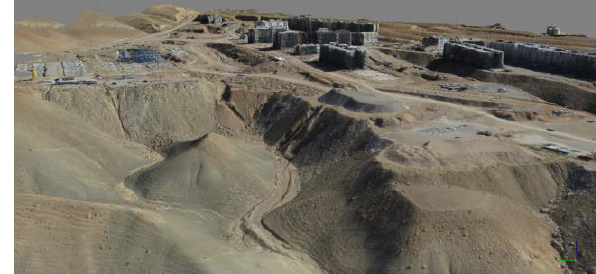
Figure 1: 3D realistic modelling of MASKAN MEHR construction site by UAV Photogrammetry